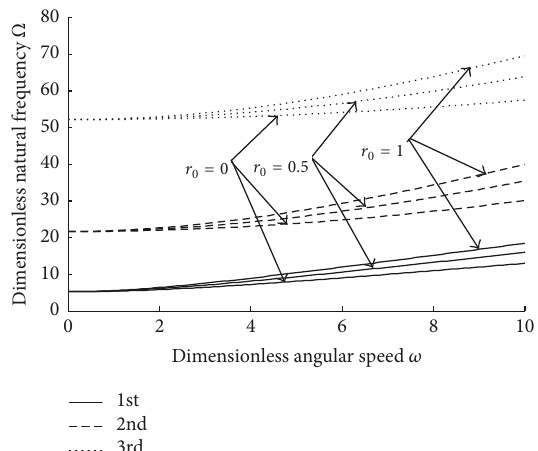
Figure 12: The first three-order dimensionless natural frequencies with ratios of hub radius to beam length for 𝑟 = 1/30 , 1/10 at 𝜔 = 5 , 𝜆 = 0.5 , and 𝛽 = 0.3